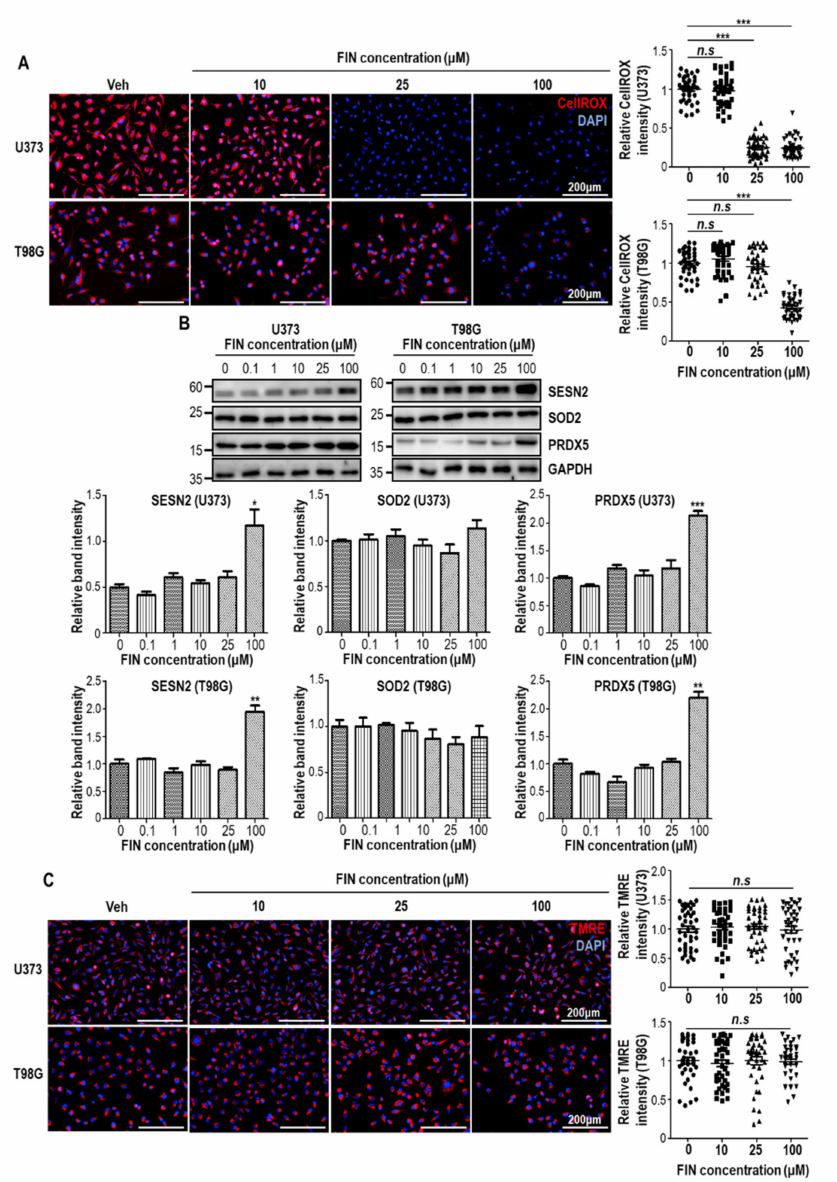
Figure 3. High-dose finasteride shows the antioxidant potential in glioblastoma cells. ( A ) U373 (upper) and T98G cells were subjected to CellROX staining after treatment with vehicle or finasteride (FIN) at the indicated concentration for 24 h. Nuclear DAPI signal is shown in blue. The relative CellROX signal intensities are shown (right). Each dot means an individual cell. ( B ) Immunoblot analysis of SESN2, SOD2, and PRDX5 in U373 (left) or T98G (right) cells after treatment with vehicle or FIN at the indicated concentration for 24 h. GAPDH was used as a loading control. The relative band intensities of SESN2, SOD2, and PRDX5 are shown below. The intensities of vehicle-treated samples were arbitrarily set to 1. ( C ) U373 (upper) and T98G cells were subjected to TMRE staining after treatment with vehicle or finasteride (FIN) at the indicated concentration for 24 h. Nuclear DAPI signal is shown in blue. The relative TMRE signal intensities are shown (right). Each dot means an individual cell. * p < 0.05, ** p < 0.01, *** p <